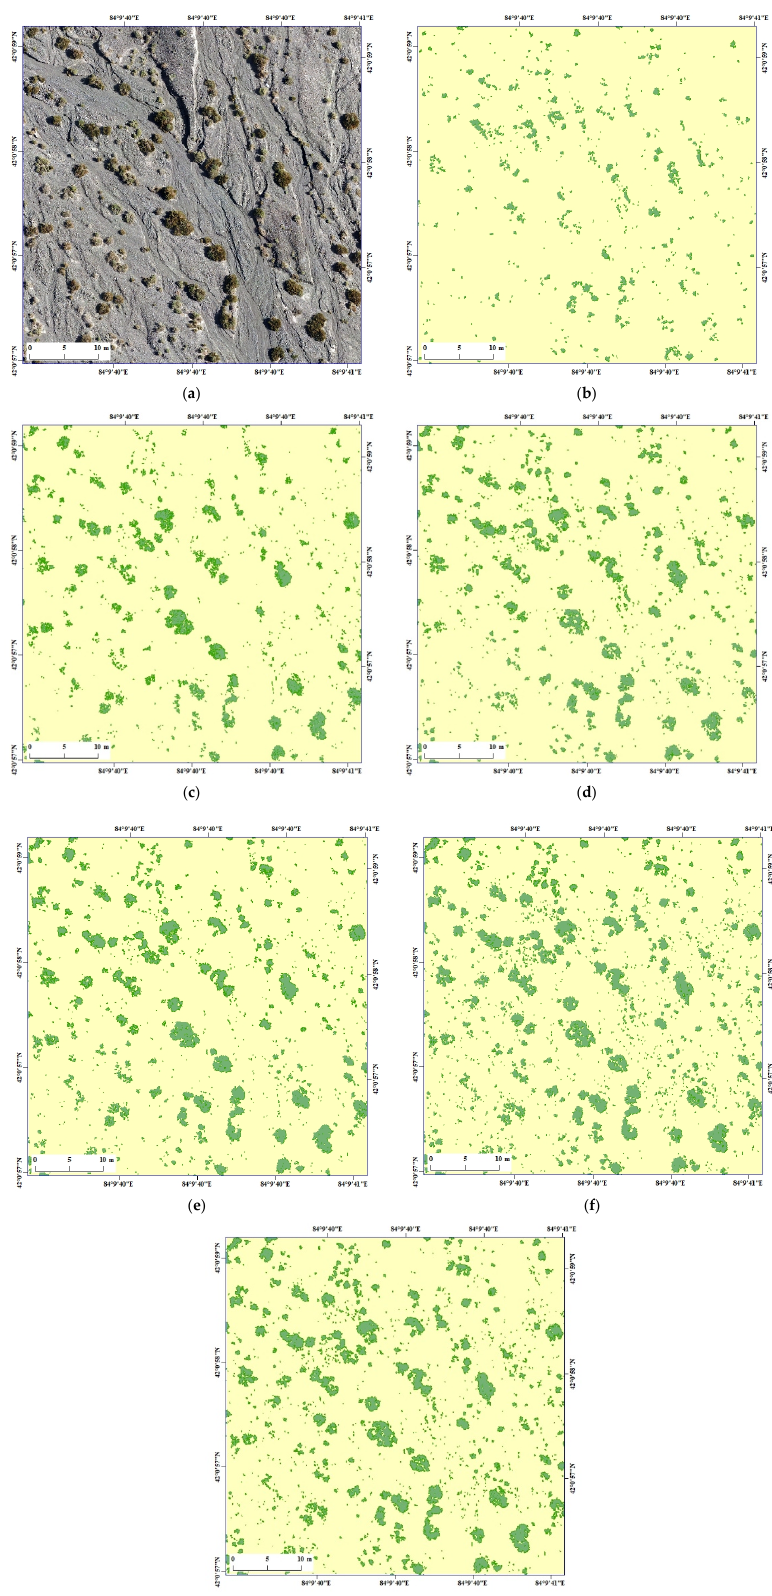
Figure 2. Classification results based on UAV images for different VIs of Gobi Desert: ( a ) UAV orthophoto; ( b – g ) the shrub crown of EXGR, GBRI, VEG, RGBVI, GLI and EXG calculated based on a fixed threshold, respectively.